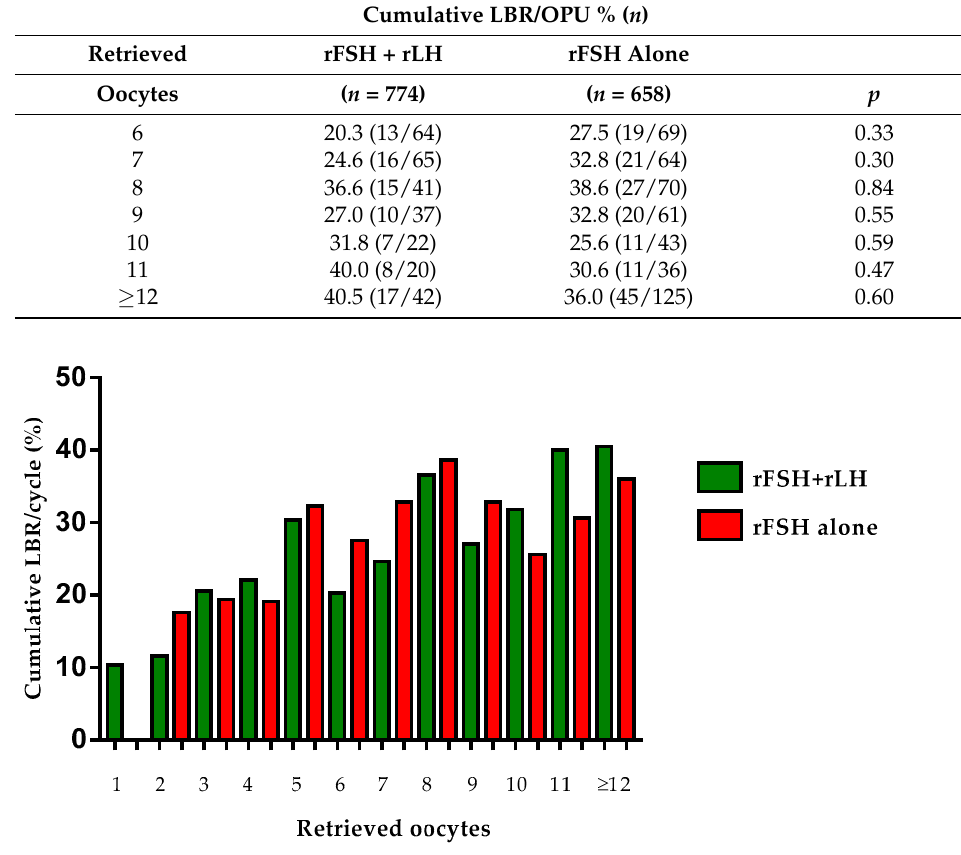
Figure 1. Cumulative live birth rates of all patients with available oocytes ( n = 1432) receiving COS with rFSH + rLH ( n = 774) or rFSH alone ( n = 658), stratified for to the number of retrieved oocytes at OPU.